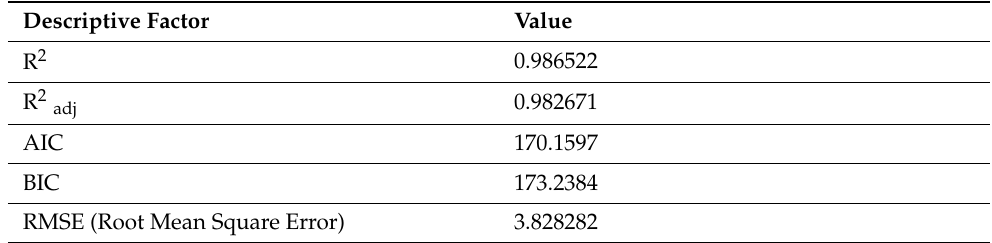
Table 3. The selected regression model (all interactions